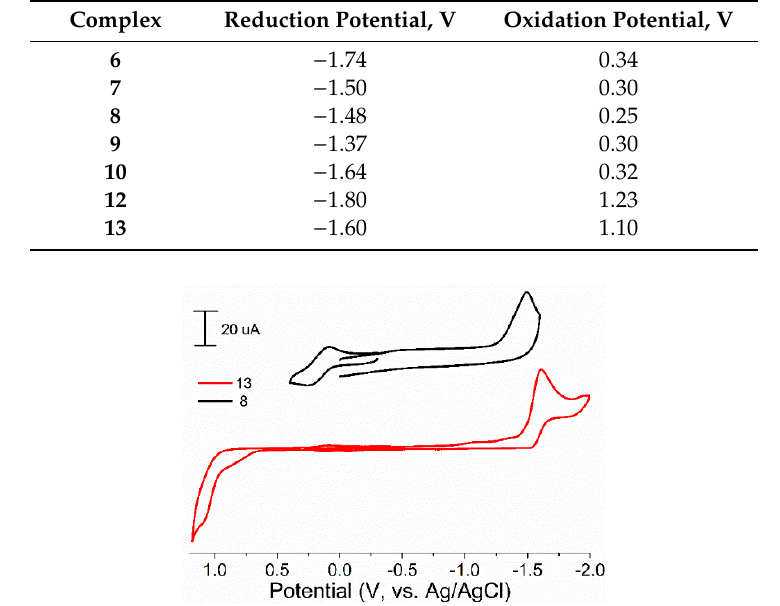
Figure3. Cyclicvoltammogramsforcomplexes 8 and 13 inMeCN.Conditions: workingelectrode-glassy Figure 3. Cyclic voltammograms for complexes 8 and 13 in MeCN. Conditions: working electrode- carbon, auxiliary electrode-Pt, supporting electrolyte-Bu 4 NBF 4 glassy carbon, auxiliary electrode-Pt, supporting electrolyte-Bu 4 NBF 4 .